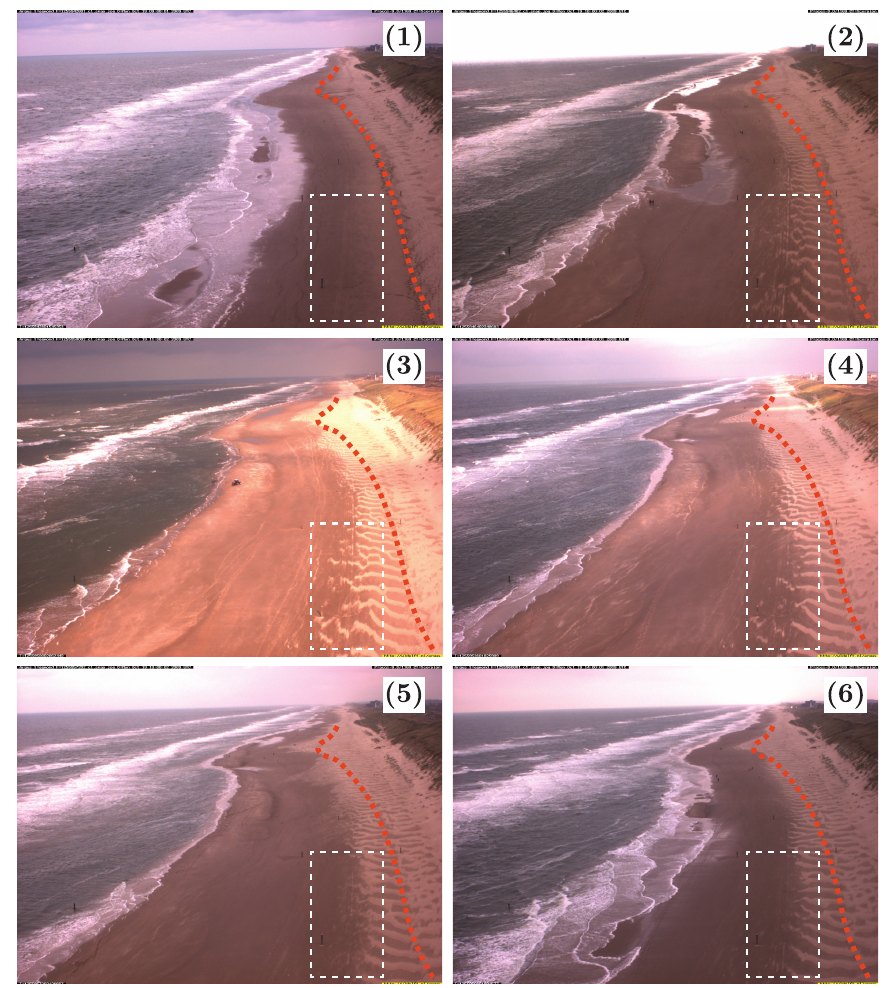
Figure 7. Aeolian sand transport observed from 6 chronological snapshots at Egmond Beach (Argus Images, 19 October 2009. (1) 9:00 h–(2) 10:00 h–(3) 11:00 h–(4) 12:00 h–(5) 13:00 h–(6) 14:00 h). The red-dashed line represents the spring high tide line and the enclosed white-dashed area serves as a guide to observe the transport in the images. The average wind speed during these hours ranged between 9 and 12 m/s, and the wind direction varied between 190 ◦ –220 ◦ , being alongshore at 9:00 h and southwest wind at 14:00 h. No rain was measured during this